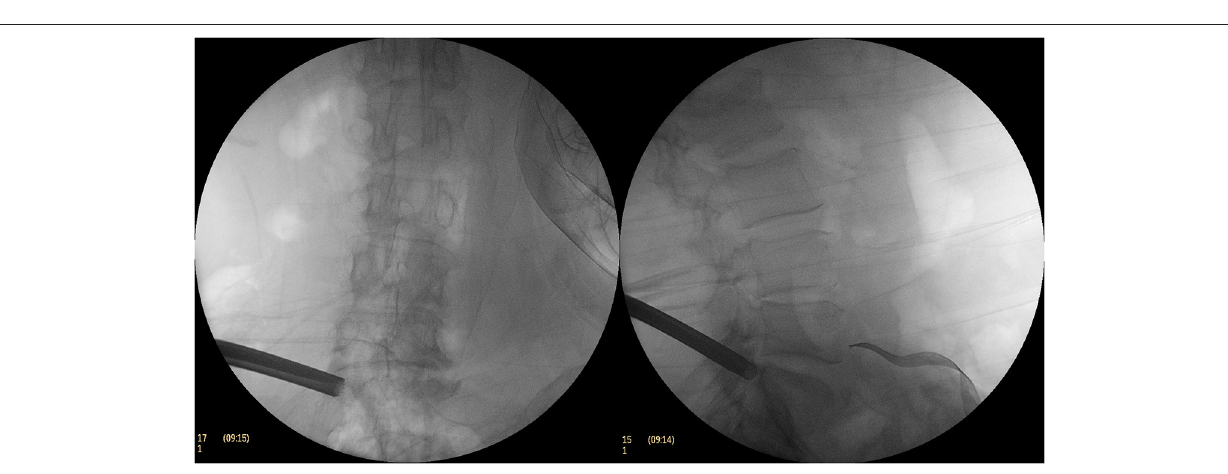
and the ventral side of the nerve root was explored to check the integrity of the posterior longitudinal